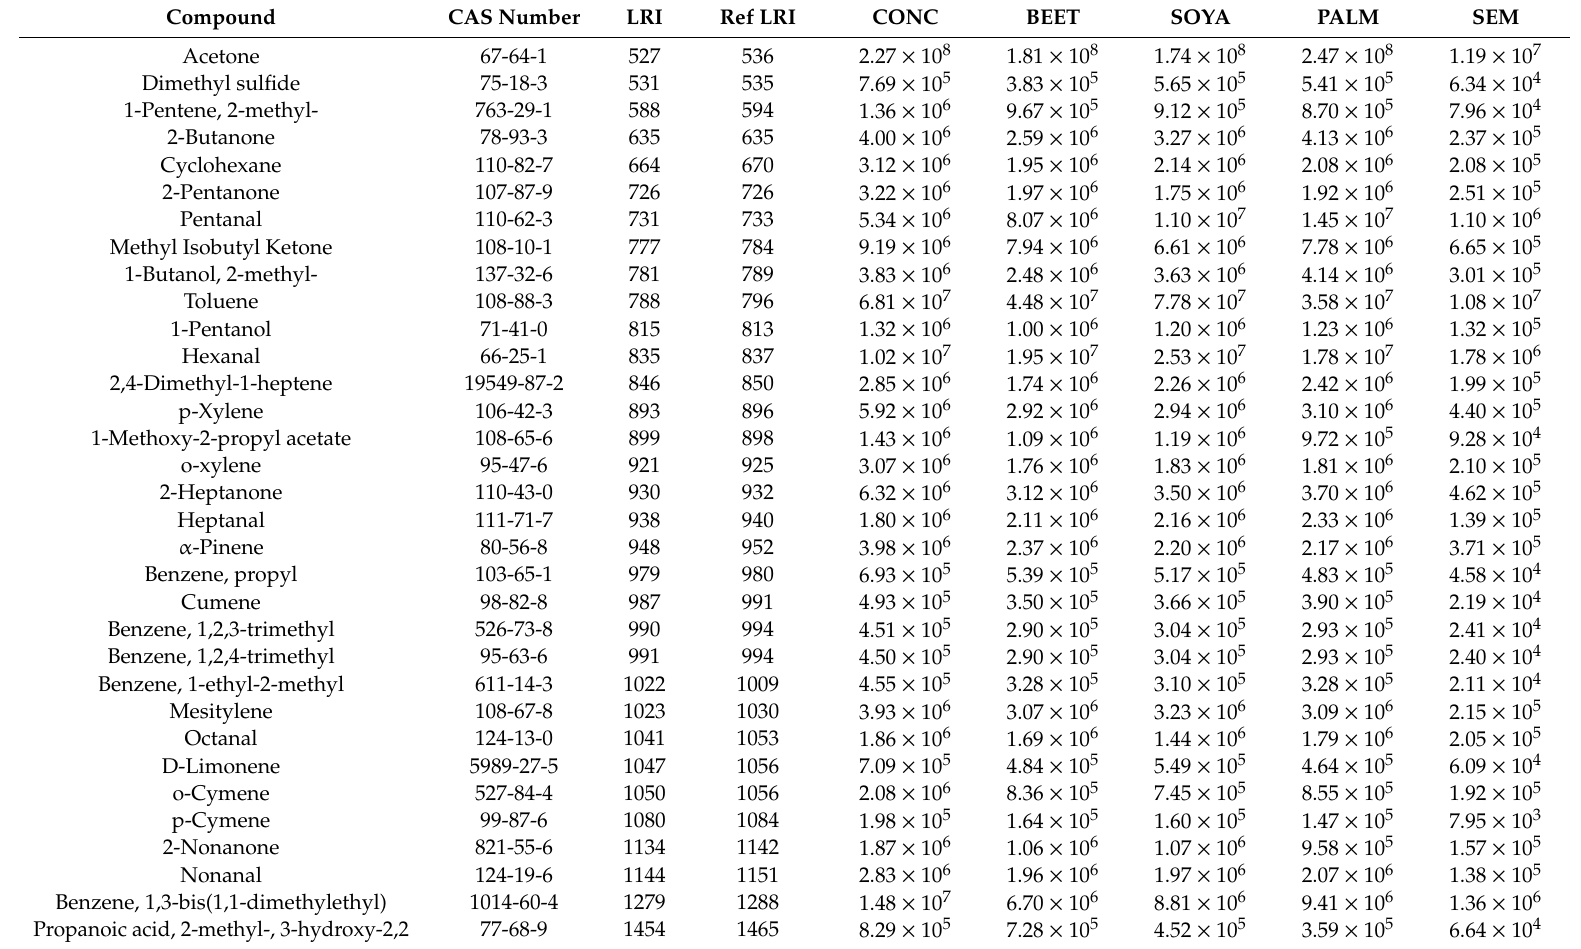
Table 9. Volatile profile of raw milks derived from pasture feeding systems supplemented with CONC, BEET, SOYA, or